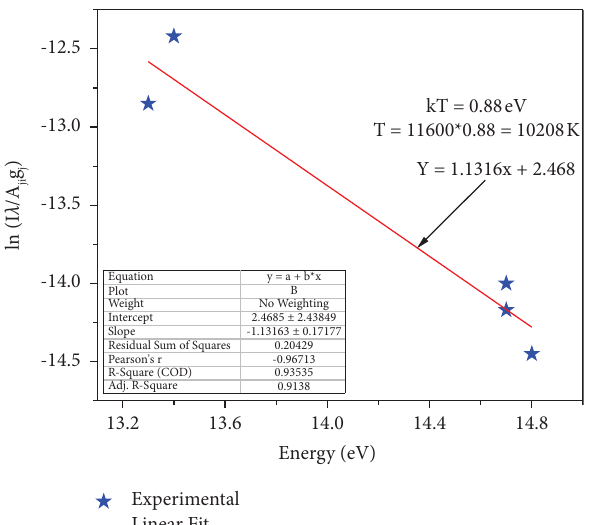
Figure 4: Estimation of excitation temperature.